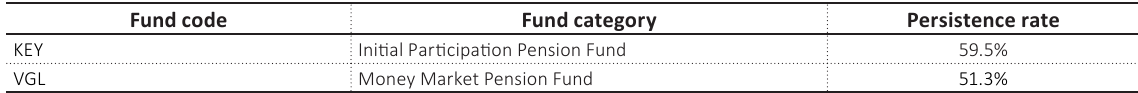
Table 10. Performance measures of persistent pension funds